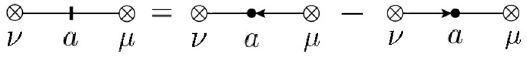
Figure 18 . In these graphs, c 1 denotes the node 1 , which is the highest-weight node in the reference order. The master chain in each graph is colored blue while a chain of the form 2 k · F . . . F · 2 k is colored red. By transforming the nodes step by step, graph (a) can be decomposed into graphs in three categories: (a-1-1-1) in category-1, (a-2) and (a-1-2) in category-2, and (a-1-1-2) in category-4. Similarly, graph (b) is decomposed into (b-2) in category-3 and (a-1) in category-4.